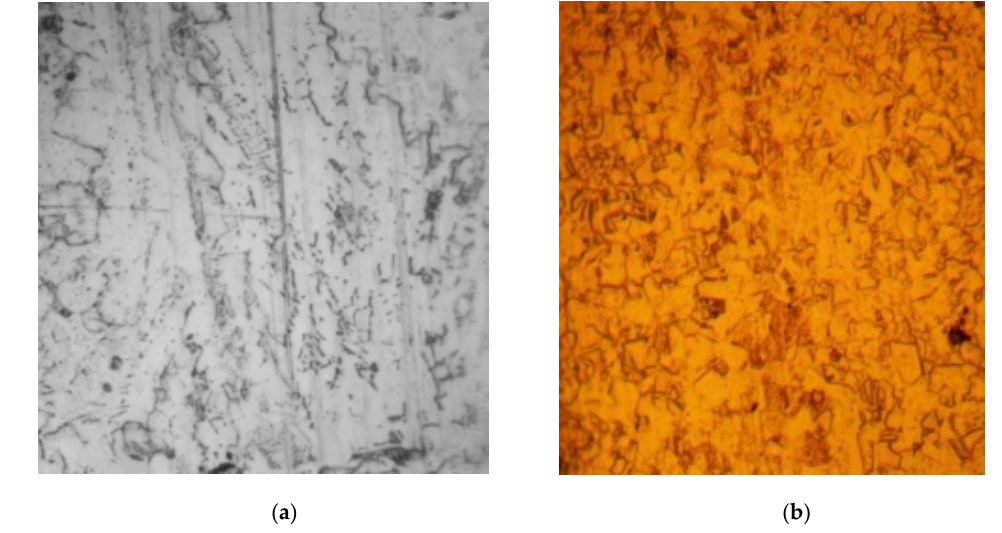
Figure 6. The microstructure of the fusion zone ( a ) and HAZ ( b ) at higher values of the mode parameters ( × 500).